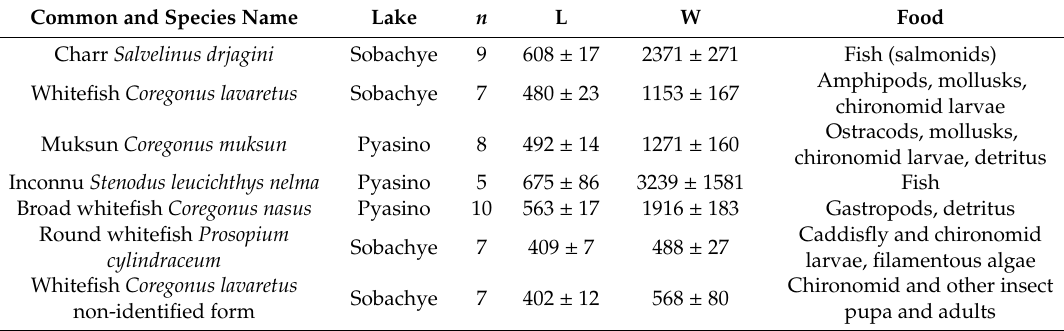
Table 1. The basic biological and sampling information on fish species (Salmoniformes order) from Siberian arctic lakes, 2017: n —number of sampled individuals; L—total length, cm (mean ± SE); W—total weight, g (mean ± SE); Food—items found in